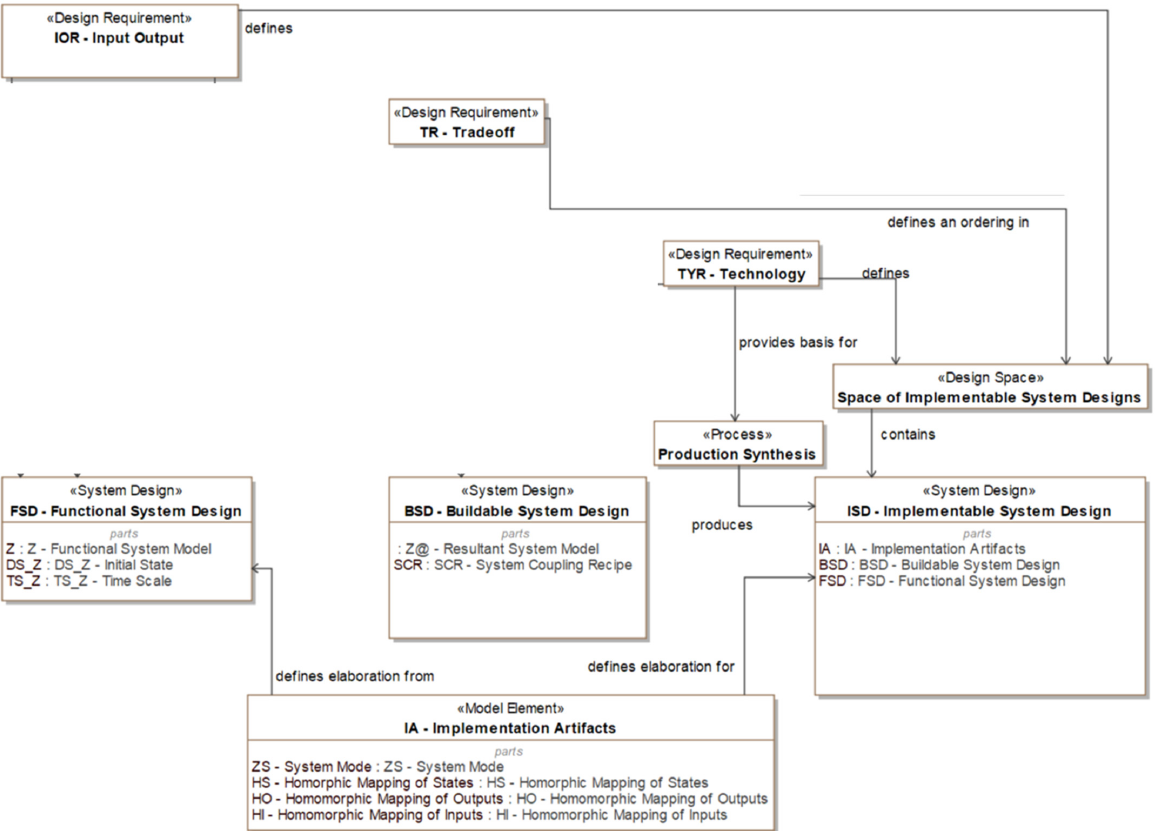
Figure 7. A description of the T3SD Implementable Perspective showing designs that meet the required input/output, have a homomorphic relationship between the functional and buildable designs, meet the required technology, and are ordered according to the preferred tradeoff between performance and cost